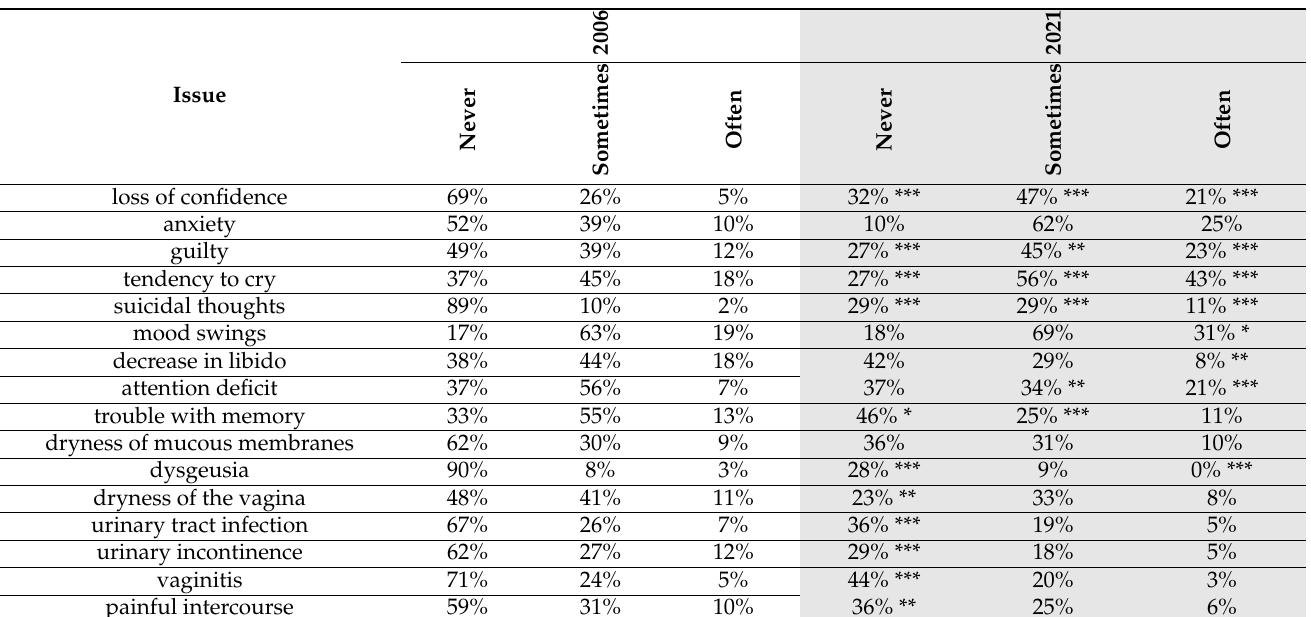
Table 4. Symptoms accompanying menopause in 2006 and